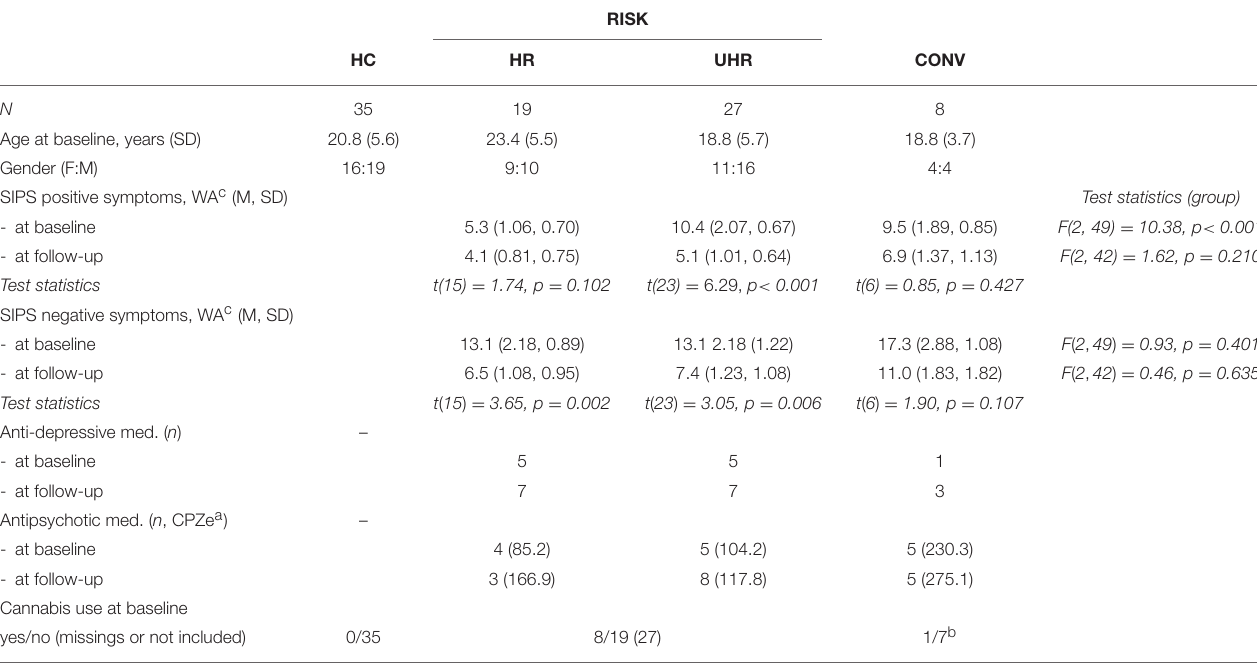
TABLE 1 | Descriptive characteristics of the subjects from the high-risk (HR), the ultra-high-risk (UHR) for schizophrenia and the converter (CONV) groups included in the follow-up analysis compared to the healthy control (HC)